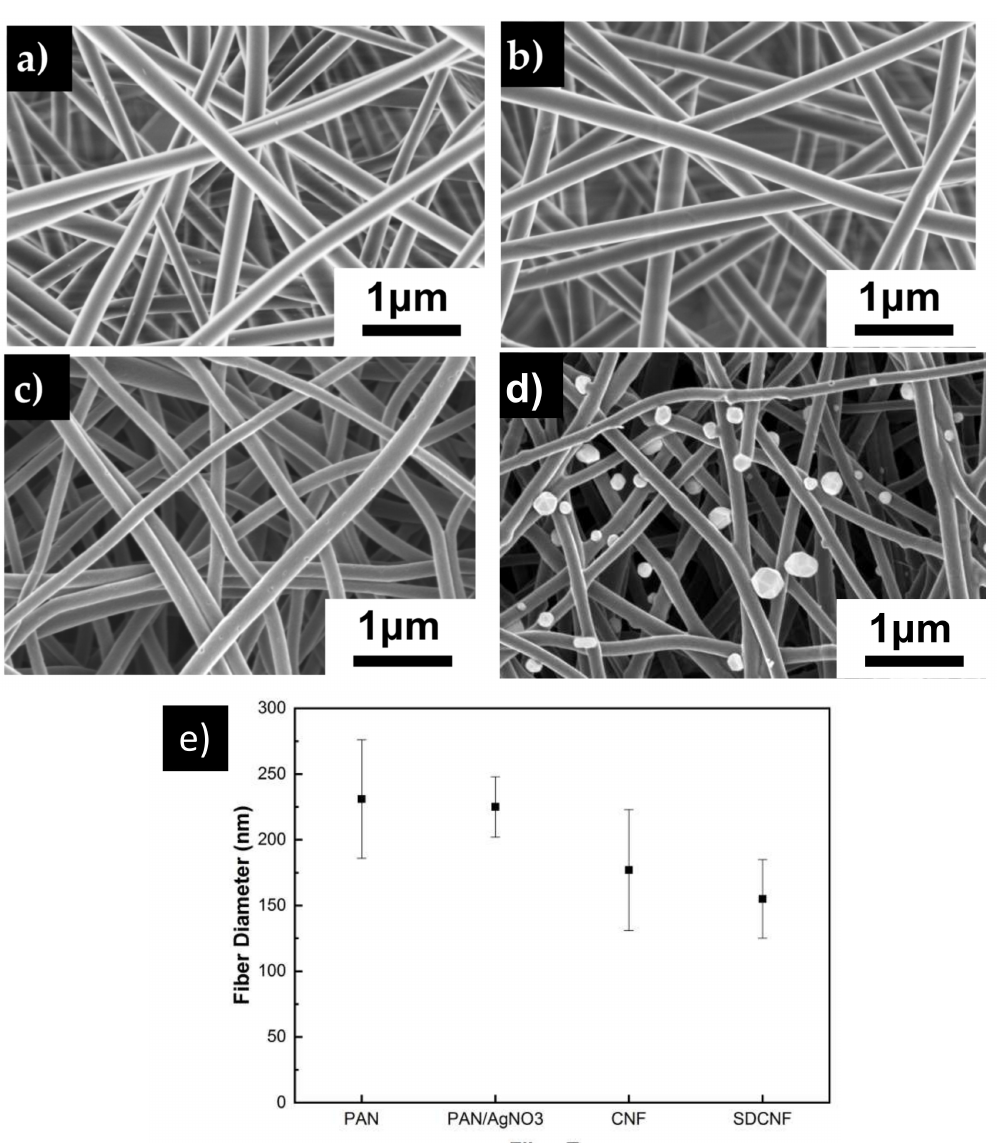
Figure 3. SEM images of electrospun membrane a ) PAN b ) PAN / AgNO 3 c ) carbon nanofiber d ) silver doped carbon nanofiber. e ) Average fiber diameters for the previously mentioned fibers. Error bars represent standard deviation for each